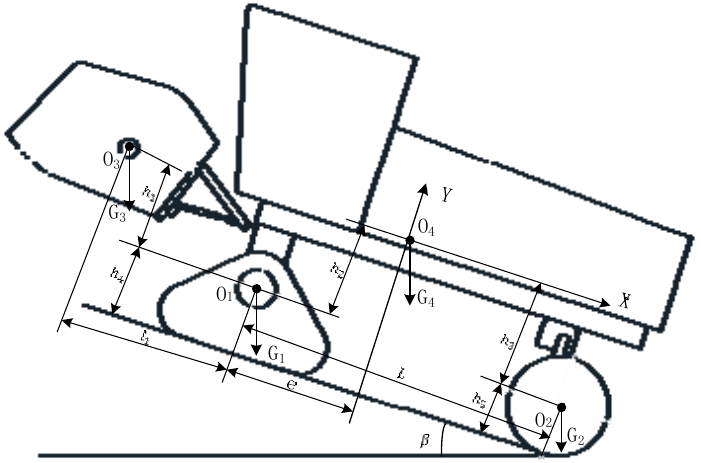
Figure 4. Schematic of the rape windrower when climbing up.